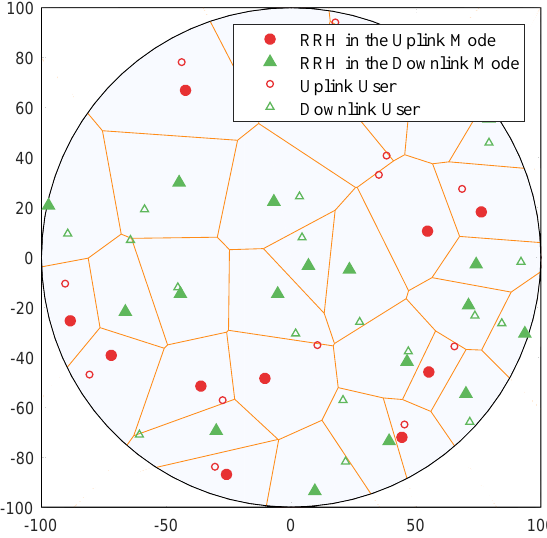
Figure 1. A diagram of the RRH and user deployment of the NAFD system.